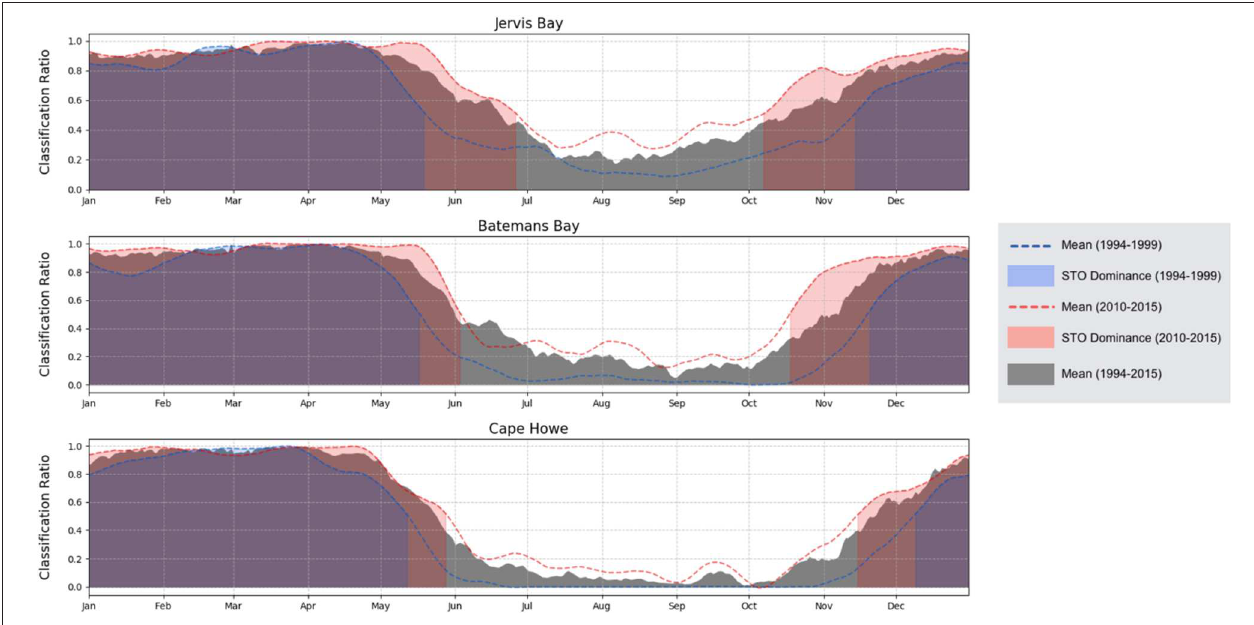
FIGURE 6 | Figure showing the typical seasonal cycle of East Australian Current (EAC) presence for each study site for each day of the year. The y-axis depicts the “classification ratio” which is the proportion of a study site’s grid cells that were classified as being subtropical origin (STO) water to those classified as Tasman Sea origin (TSO) water. The gray shaded area represents the mean seasonal cycle for each day of the year for the entire study period (1994–2016). The dashed lines show the mean seasonal cycle for each day of the year after the application of a Savitzky–Golay smoothing function (window length = 35, polynomial order = 3) for the first 5 years of the dataset (blue = 1994/01/01 to 1999/12/31) and last full 5 years of the data set (red = 2010/01/01 to 2015/12/31) with the respective colored shaded areas indicating the season when the classification ratio is > 0.5 (period when the STO water is